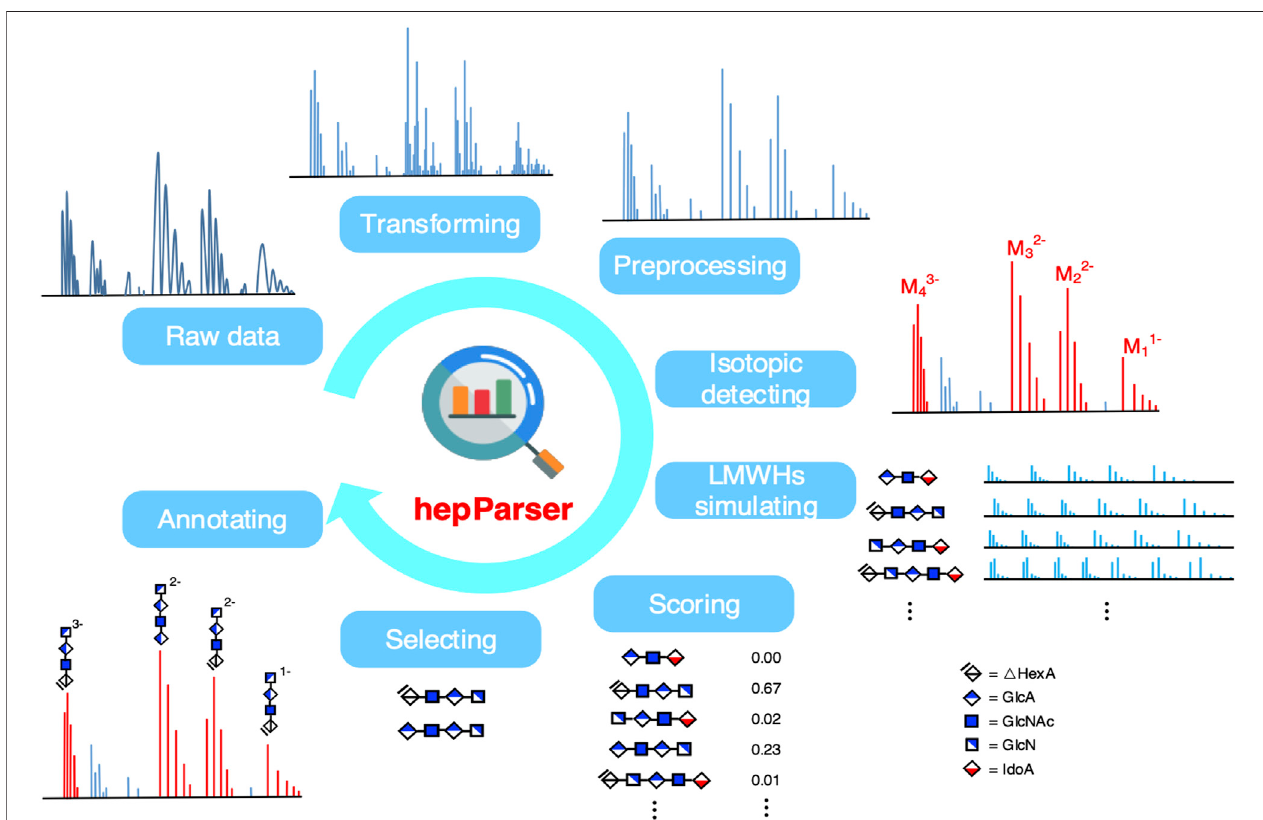
FIGURE 1 | Work fl ow of hepParser to decipher components of LMWHs.